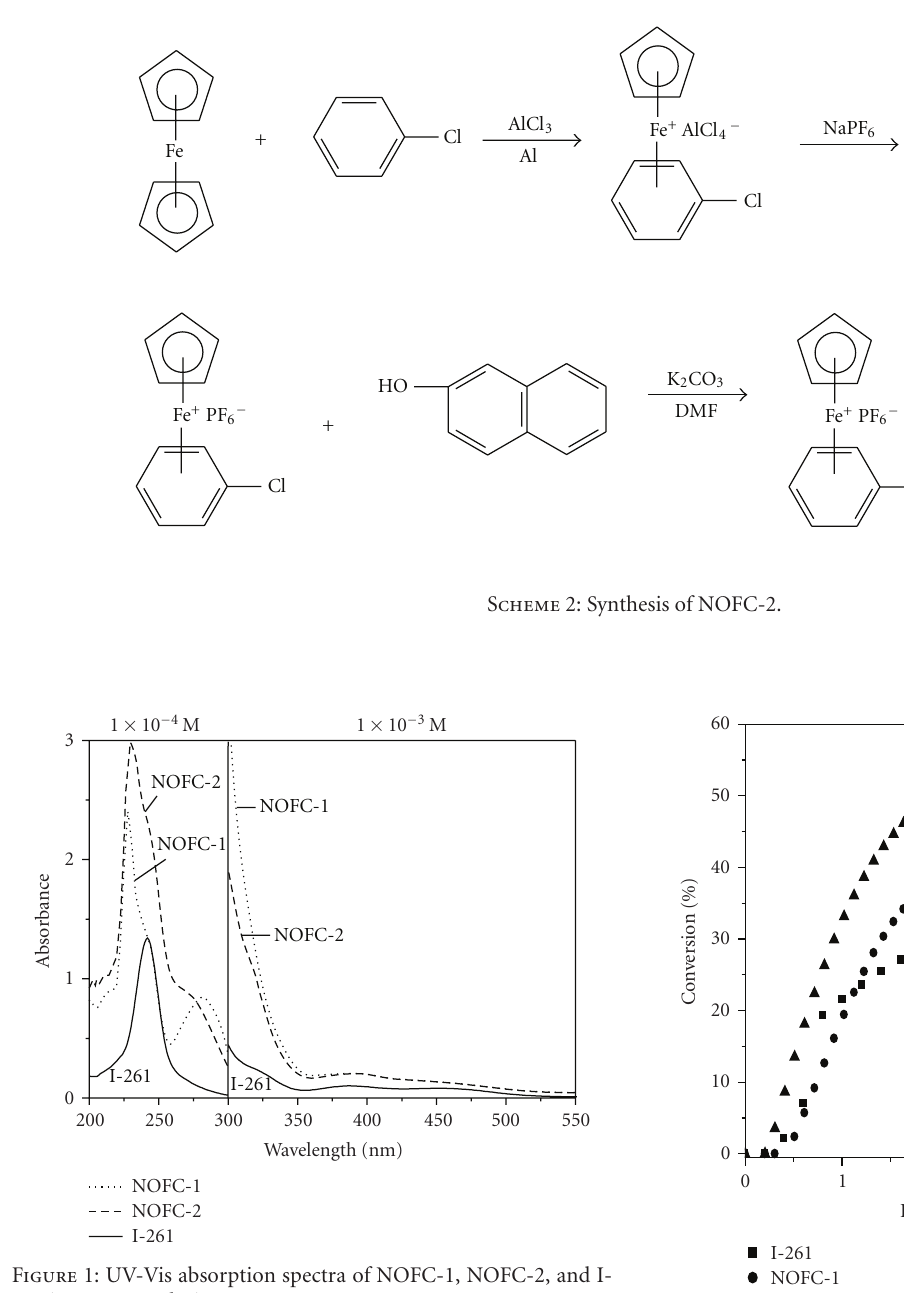
Figure 1: UV-Vis absorption spectra of NOFC-1, NOFC-2, and I- 261 in CH 3 CN solution.